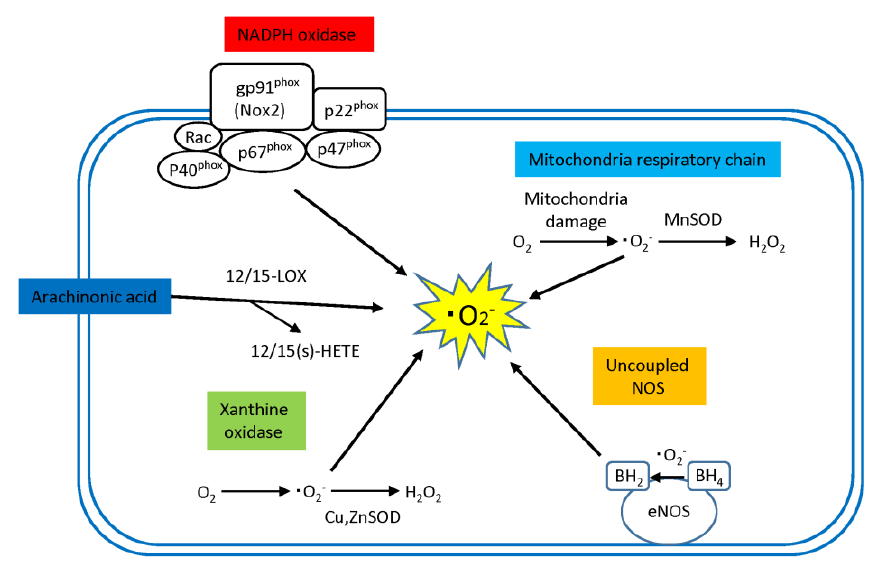
Figure 2. Sources of ROS in the diabetic heart. NADPH oxidase, mitochondria respiratory chain, Arachidonic acid (AA), xanthine oxidase and uncoupling of NOS are major source of ROS in the diabetic heat. Activated NADPH, dysfunctional mitochondrial respiratory chain, decreased availability of tetrahydrobiopterin (BH 4 ) in uncoupled eNOS, activated 12/15-LOX pathway in AA and xanthine oxidase generate superoxide anion (·O 2− ) in the heart. SOD isoforms, MnSOD, and CuZn SOD dismutate superoxide anion (·O 2− ) to produce hydrogen peroxide (H 2 O 2 ). Superoxide anion (·O 2− ), hydrogen peroxide (H 2 O 2 ), hydroxyl radical (·OH), endothelial nitric oxide synthase (eNOS), superoxide dismutase (SOD), dihydrobiopterin (BH 2 ), tetrahydrobiopterin (BH 4